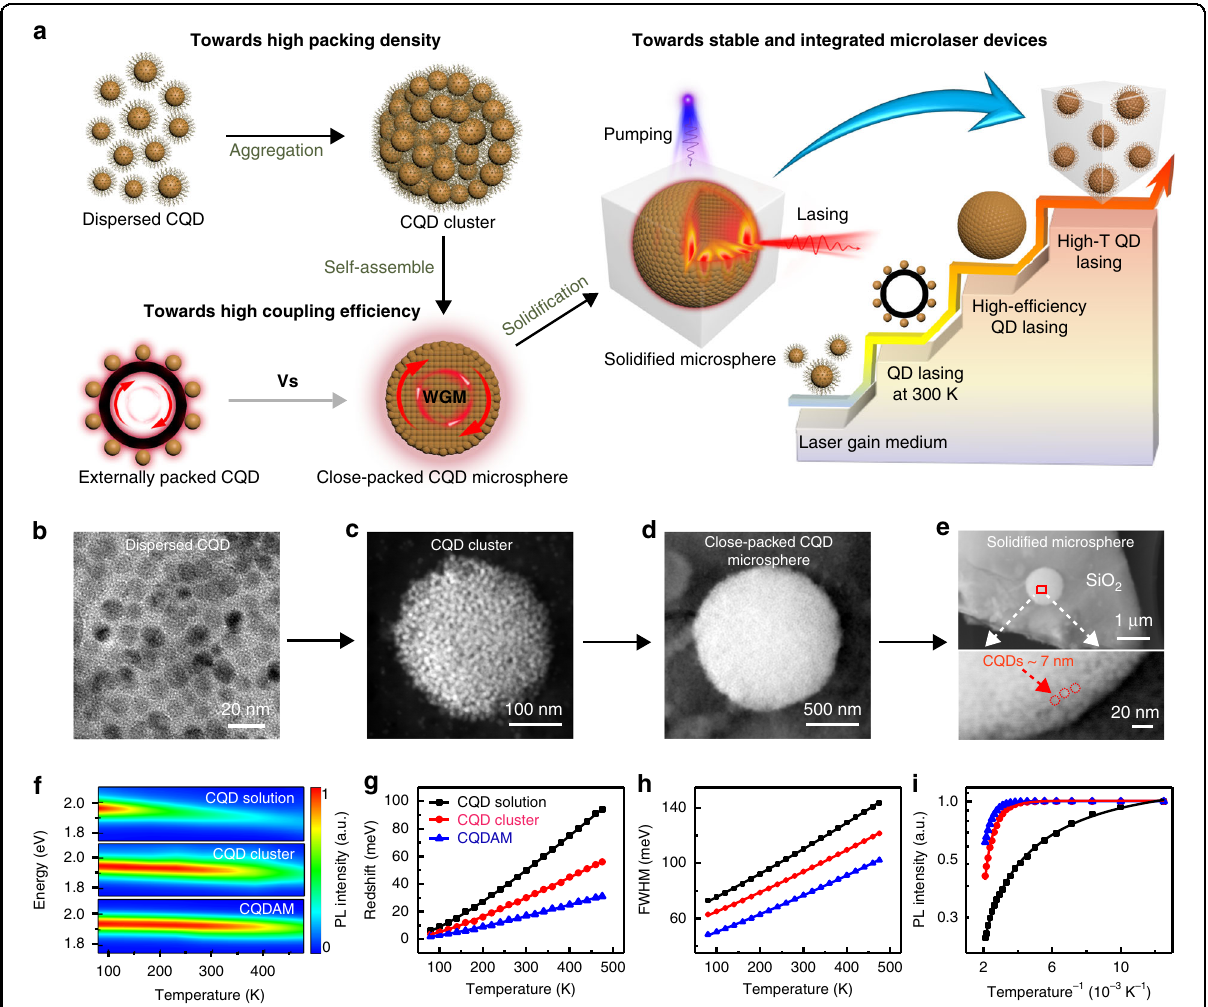
Fig. 1 Schematic of experimental design and morphology characteristics of different CQD structures. a Schematic of the three core problems of CQD laser research and the corresponding solutions of our work for achieving high-temperature CQD lasers. Dispersed CQD self- assembling into closely packed CQD cluster to achieve high packing density, then to the CQD-assembly microsphere to achieve high coupling ef fi ciency, fi nally to the solidi fi ed microsphere to achieve stable and integrated high-T laser. The CQD-assembly microsphere can serve as both gain medium and microcavity. Lights travel inside the WGM microcavity due to the total internal re fl ection at the resonator boundary to achieve high coupling ef fi ciency. CQDAMs are solidi fi ed in silica matrix through sol – gel method to ensure stable working at high temperatures. b – e TEM images of different CQD structures, corresponding to the model in ( a ). f Contour plots of the temperature-dependent emission from different CQD structures with the temperature varied from 77 to 475 K under the same excitation conditions. g – i Evolution of emission peak redshifts ( g ), spectral full-width at half-maximum (FWHM) ( h ), and PL intensity ( i ) for the three different CQD structures with the increase of